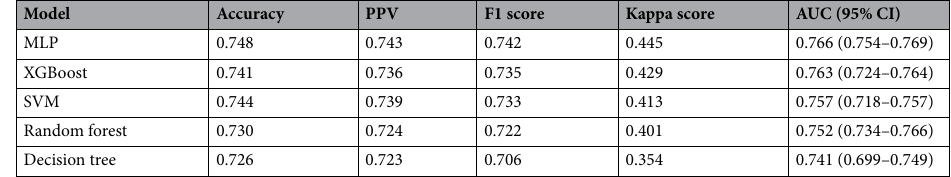
Table 2. Model performance in testing data according to ranking. PPV, positive predictive value; AUC, area under curve; CI, confidence interval; MLP, multilayer perceptron; SVM, support vector machine; XGBoost, extreme gradient boosting.